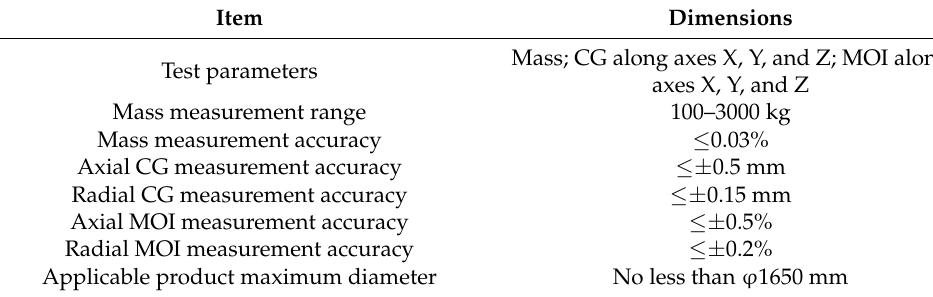
Table 2. Specification and design requirements of the systems.